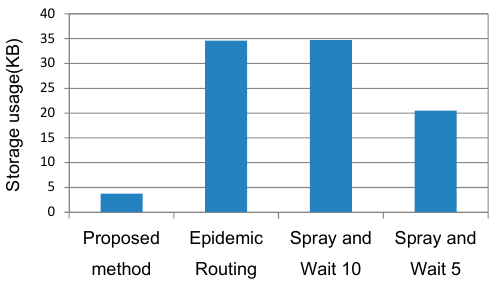
Figure 11. Average maximum storage usage of carrier